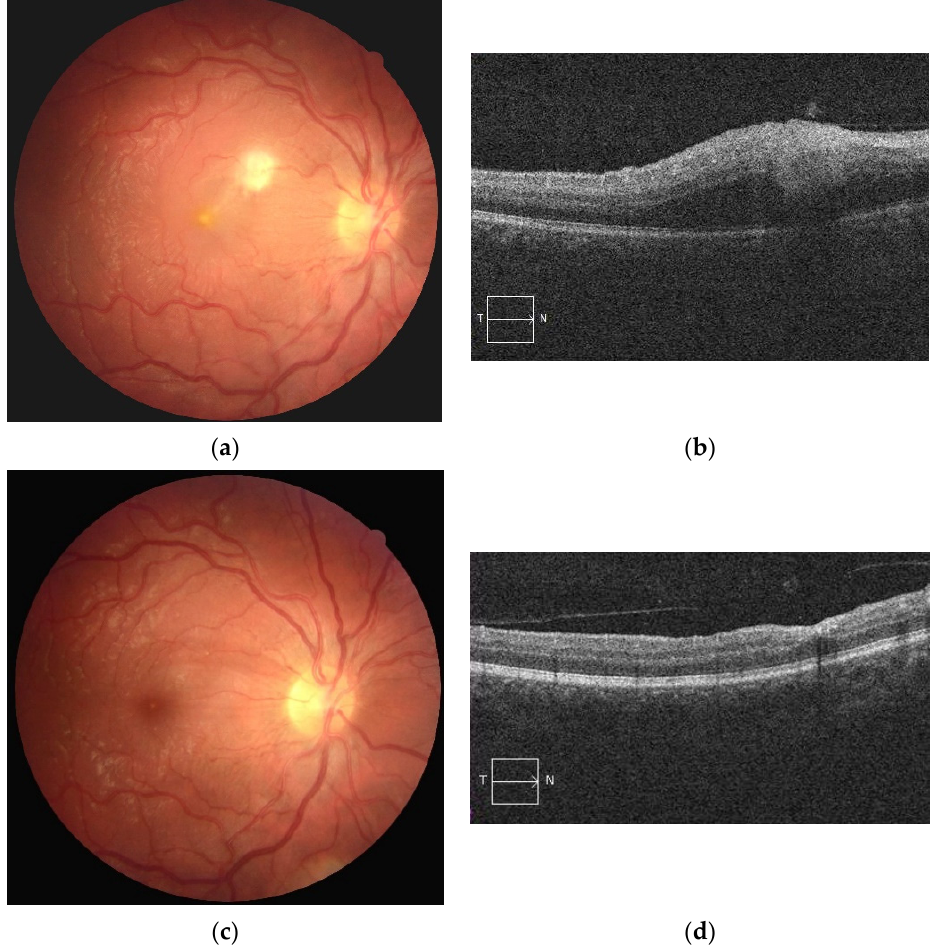
Figure 4. ( a ) Retinal photography of the right eye showing area of whitish retinal necrosis related to Behçet’s disease and ( b ) its appearance on OCT as focal inner nuclear layer thickening; ( c ) its resolution 2 months later and ( d ) its appearance on OCT as focal inner nuclear layer